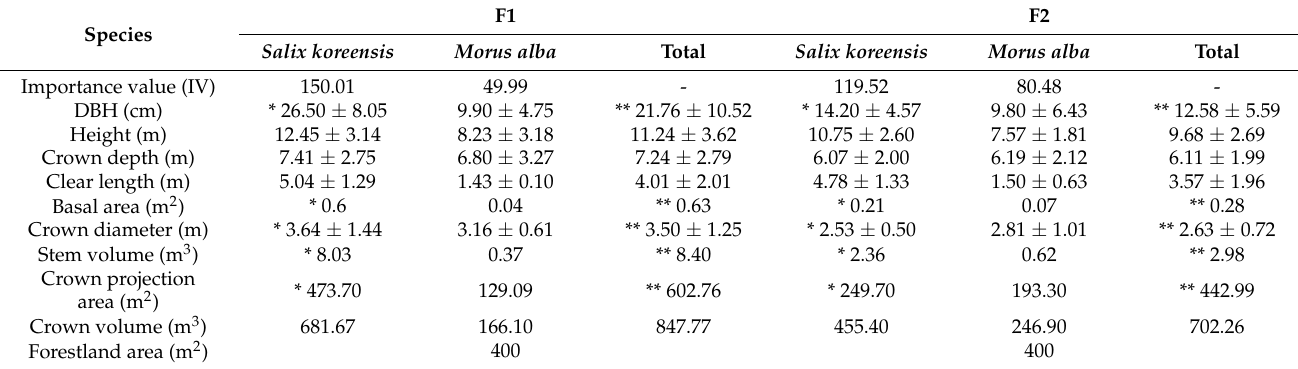
Table 1. Stand structure characteristics of two willow forest (F1 and F2) in the Yeouido Saetgang Ecological Park.